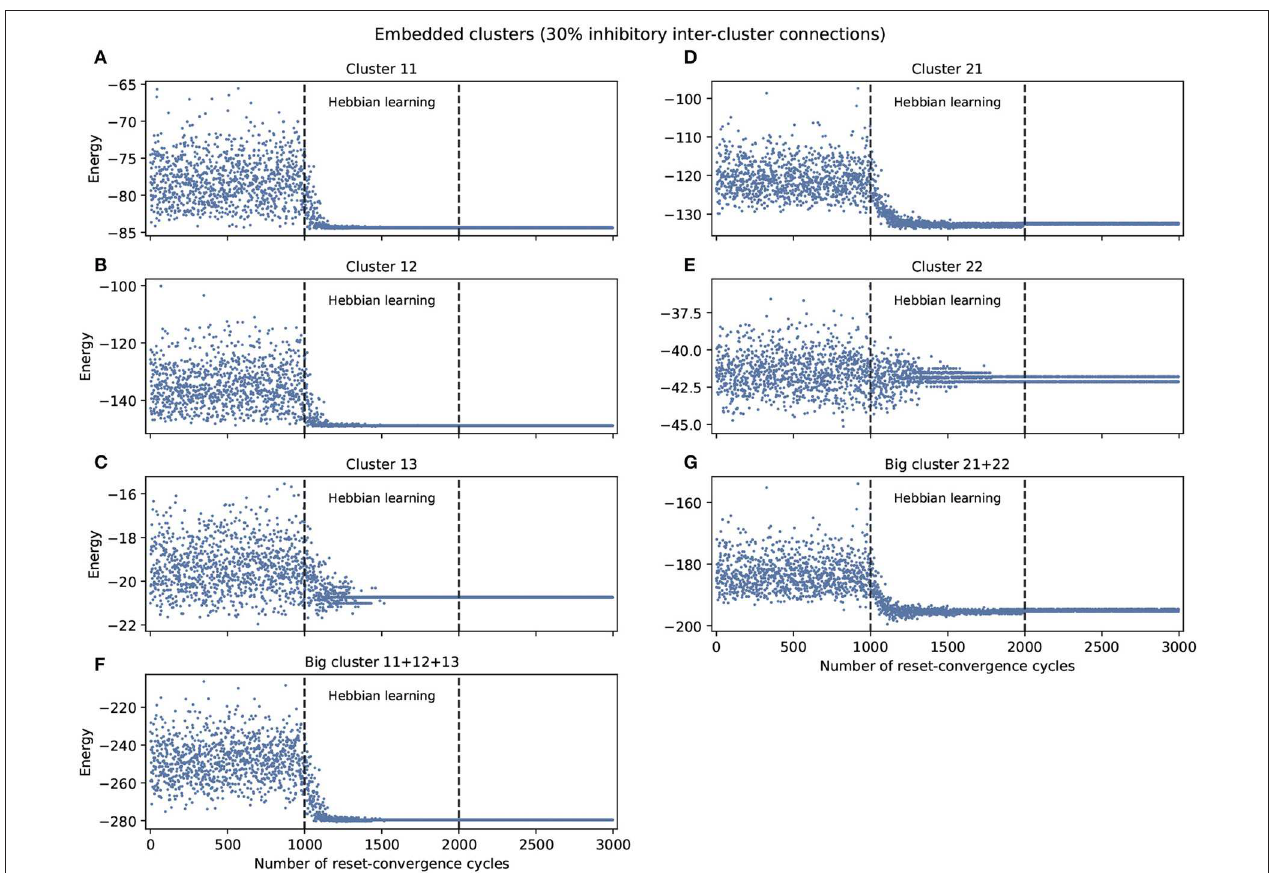
FIGURE 2 | Examples of self-optimization in different C. elegans clusters monitored in the context of a single experiment. 30% inhibitory neurons were added arbitrarily only to inter-cluster connections. The learning rate in the experiment was the same to the one used with the entire connectome and proved to be suitable in the previous work of Morales and Froese (2019). (A-E) Correspond to the clusters 11, 12, 13, 21, 22, respectively. (F,G) Belong to the two big clusters formed at a higher level from the previous: the chemosensory cluster (11+12+13) and the mechanosensory one (21+22). Each panel was averaged from 10 different experiments and shows the energy of the neuron states in three distinct phases: before learning (1-1,000), during the self-optimization process (1,001-2,000), and after learning (2,001-3,000). Self-optimization can be observed in almost all panels, but in this case the global attractors tend to be punctual. Some clusters like 22 represent a complex case for the algorithm. Energy values averaged in (C) for cluster 13 before self-optimization produce − 19.35(1.13 SD), during self-optimization − 20.64(0.42 SD), and after self-optimization − 20.74(0